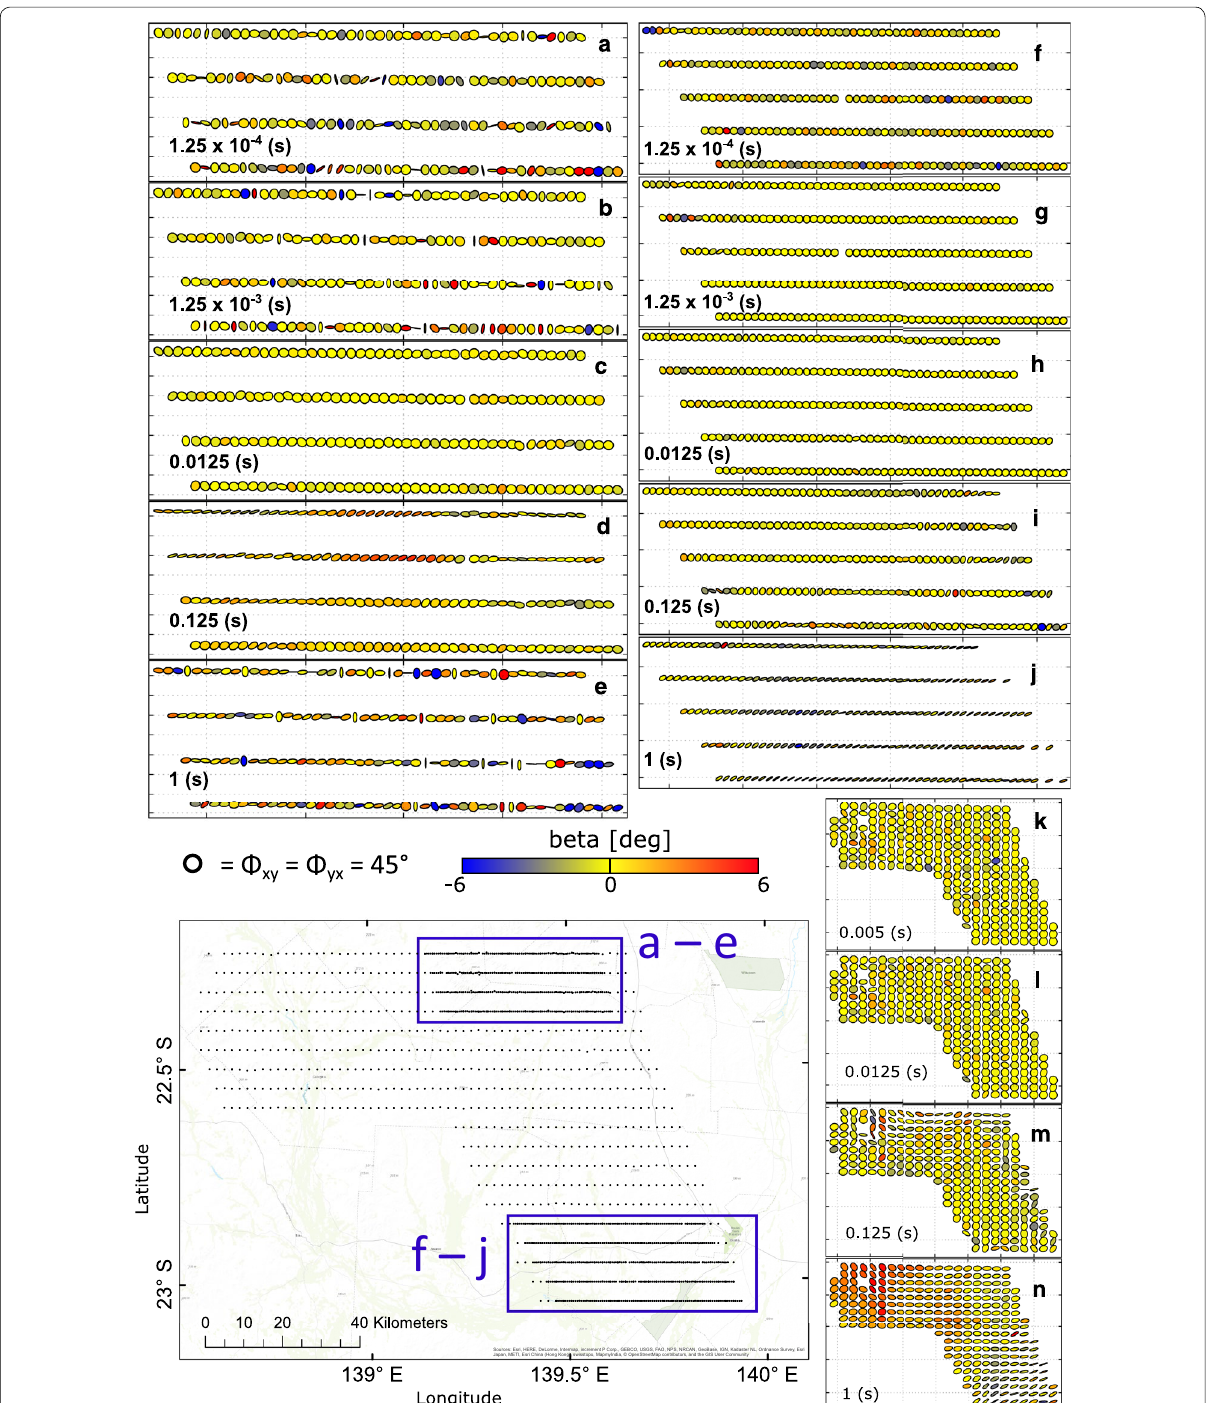
Fig. 4 Phase tensor plots coloured by skew for AMT and BBMT datasets (annotated with period). Data unaffected by noise are predominantly 1D at short periods, as indicated by yellow circular ellipses. Distorted ellipses with low skew values are indicative of 2D data, while ellipses with red or blue colouration indicate 3D subsurface structure. a – e north block AMT data, increased data noise responsible for scattering at 1 s, 1.25 1.25 10 − 4 s. f – j southern block AMT data. k – n data for BBMT sites, western sites are 3D at 1 s. Displayed ellipses were generated using one-third of × the total BBMT sites and half of all AMT sites for